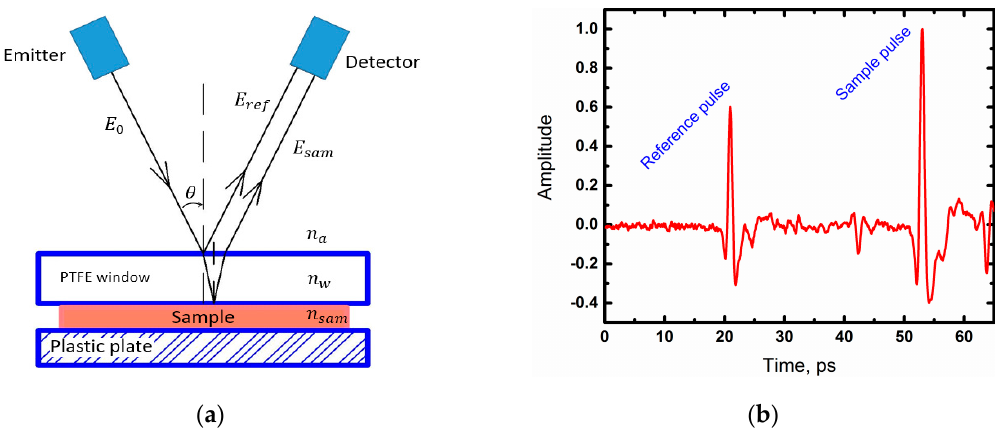
Figure 3. ( a ) Incident wave propagation in the double-reflection measurement method. 𝐸(cid:3552) (cid:2868) —incident THz field, 𝐸(cid:3552) (cid:3045)(cid:3032)(cid:3033) , and 𝐸(cid:3552) (cid:3046)(cid:3028)(cid:3040) —the THz field reflected from the air—window and window-sample interface, respectively. 𝑛 (cid:3028) , 𝑛 (cid:3050) , and 𝑛 (cid:3046)(cid:3028)(cid:3040) are the refractive indices of air, window and sample, respectively; ( b ) THz time-domain waveform corresponding to a tissue (mucosa).